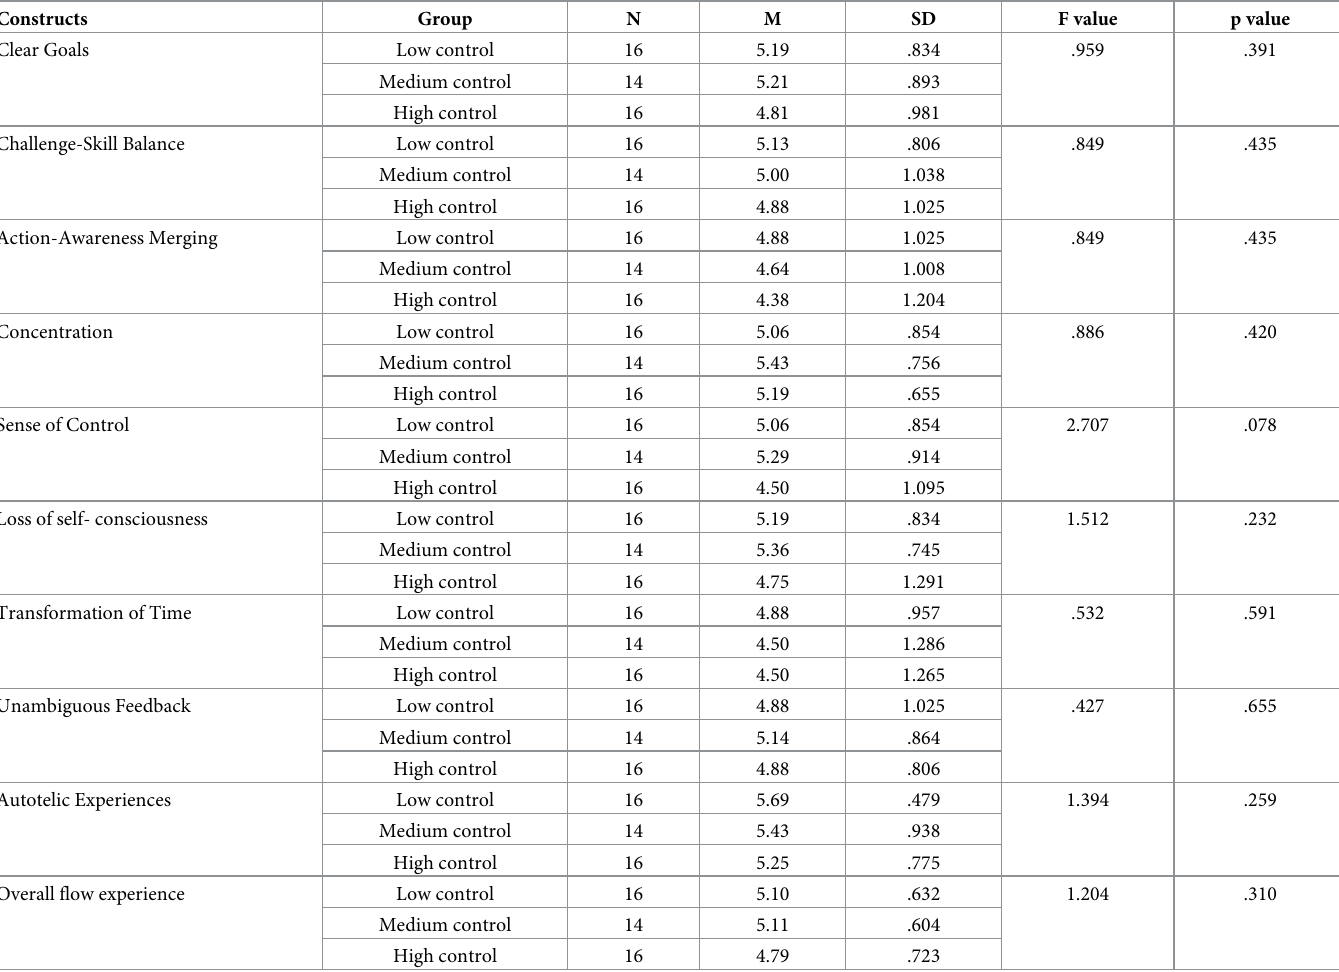
Table 4. Comparison of participants’ flow experience across